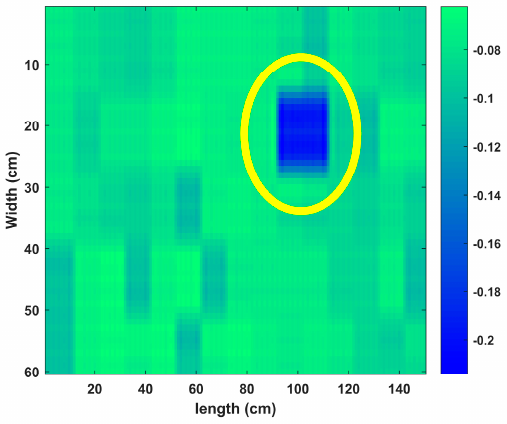
Figure 16. Radar target detection in the xy ‐ planes.